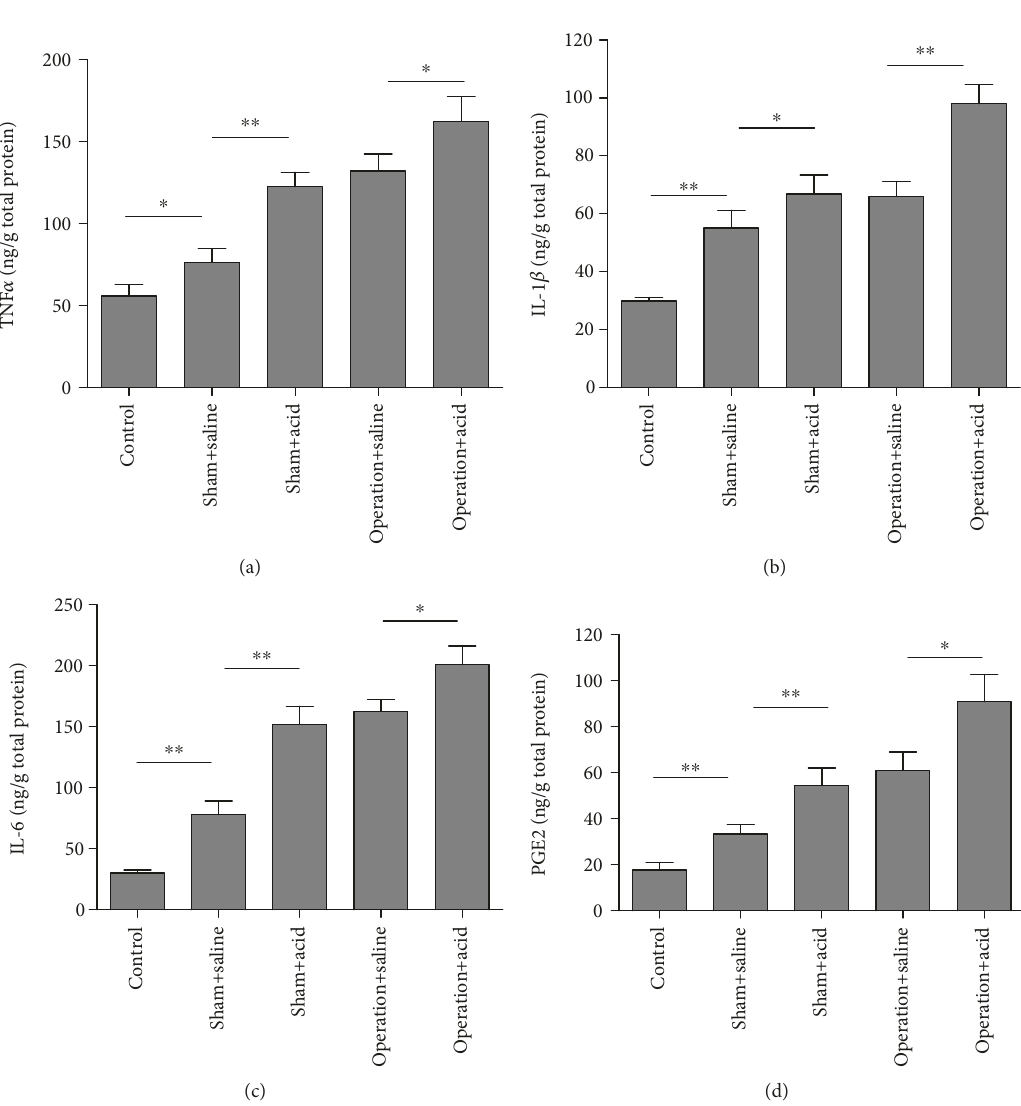
Figure 2: DMV destruction aggravated proin fl ammatory cytokine expression in an esophageal instillation model. The concentration of the cytokines TNF- α (a), IL-1 β (b), IL-6 (c), and PGE2 (d) in esophageal tissue in experimental groups more signi fi cantly increased than in the control group ( n = 8 , ∗ P < 0 05 and ∗∗ P < 0 01 ). Speci fi cally, TNF- α , IL-1 β , IL-6, and PGE2 expression more signi fi cantly increased in the esophageal tissues of the operation + acid groups compared to those of the operation + saline groups ( n = 8 , ∗ P < 0 05 and ∗∗ P < 0 01